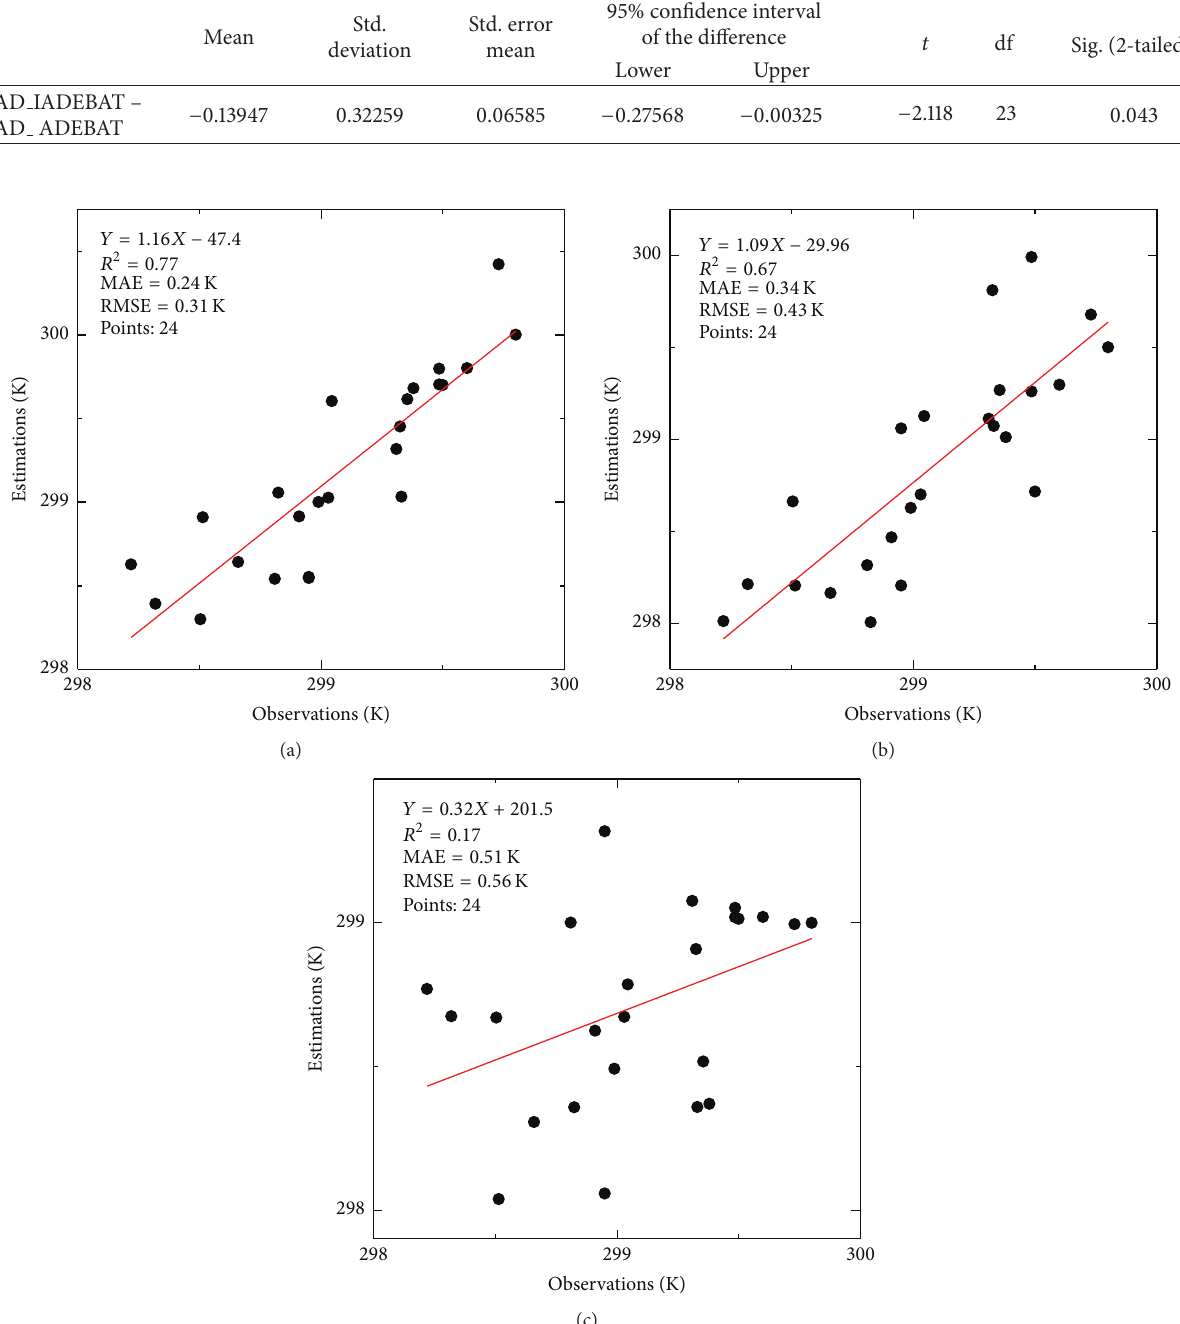
Figure 5: Comparison of air temperature derived from the IADEBAT model (a), the ADEBAT model (b), and the IDW method